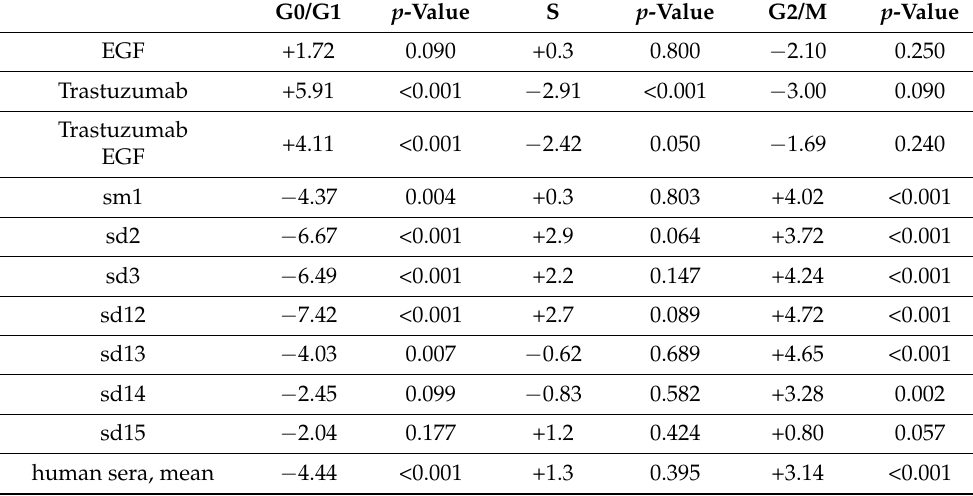
Table 1. Alteration of cell-cycle distribution upon the treatment * with trastuzumab, EGF and human blood serum of BT474 cells compared with non-treated cells, in % **. G0/G1 p -Value S p -Value G2/M p -Value EGF +1.72 0.090 +0.3 0.800 − 2.10 0.250 Trastuzumab +5.91 <0.001 − 2.91 <0.001 − 3.00 0.090 Trastuzumab +4.11 <0.001 − 2.42 0.050 − 1.69 0.240 EGF sm1 − 4.37 0.004 +0.3 0.803 +4.02 <0.001 sd2 − 6.67 <0.001 +2.9 0.064 +3.72 <0.001 sd3 − 6.49 <0.001 +2.2 0.147 +4.24 <0.001 sd12 − 7.42 <0.001 +2.7 0.089 +4.72 <0.001 sd13 − 4.03 0.007 − 0.62 0.689 +4.65 <0.001 sd14 − 2.45 0.099 − 0.83 0.582 +3.28 0.002 sd15 − 2.04 0.177 +1.2 0.424 +0.80 0.057 human sera, mean − 4.44 <0.001 +1.3 0.395 +3.14